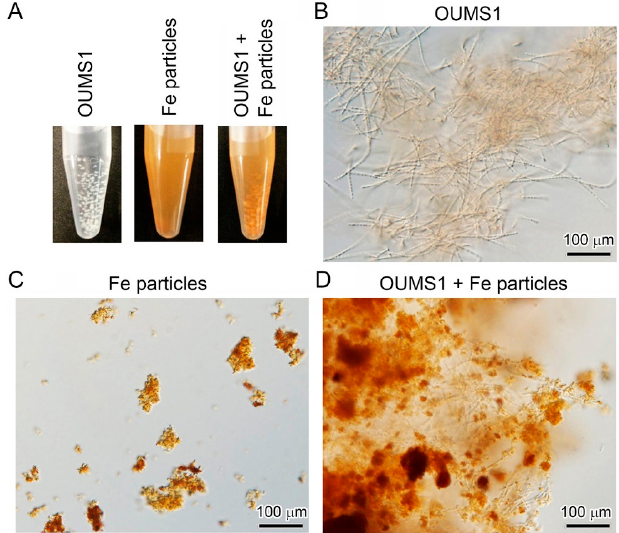
Figure 3. Fe(III) particles adhered onto sheaths of OUMS1 cultured in Fe-free medium. ( A ) Whitish primitive sheaths formed in Fe-free SGP ( left ) and abiotically generated Fe(III) particles in SGP + Fe ( middle ). Mixture of both in a tube ( right ). Note that the whitish sheaths immediately turned brownish after mixing with Fe(III) particles; ( B ) DIC images of cells and associated sheaths cultured in Fe-free medium; ( C ) Abiotically generated Fe(III) particles; ( D ) The particle assembly adhered to sheaths after mixing ( B ) with ( C ).